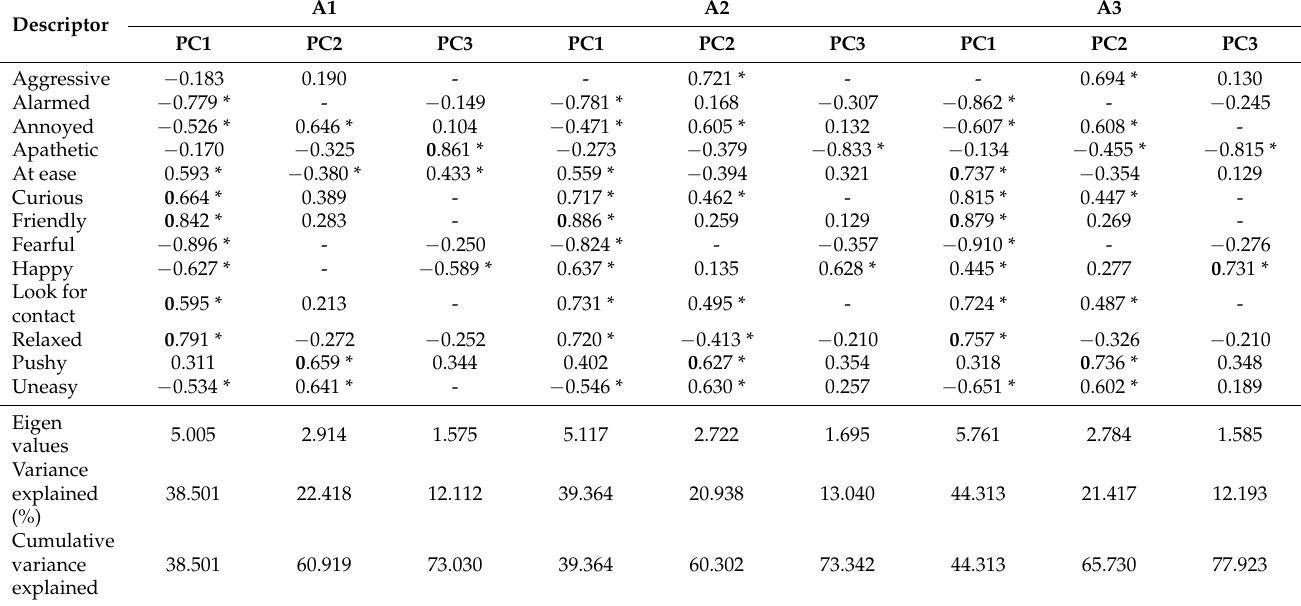
Table 5. Loadings for the QBA descriptors on the first three principal components.